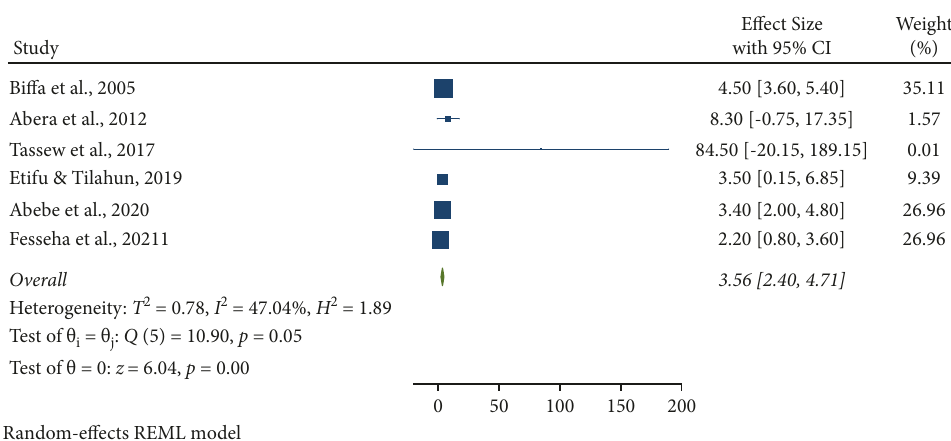
Figure 12: Previous history of mastitis as an associated risk factor for mastitis among dairy cows.